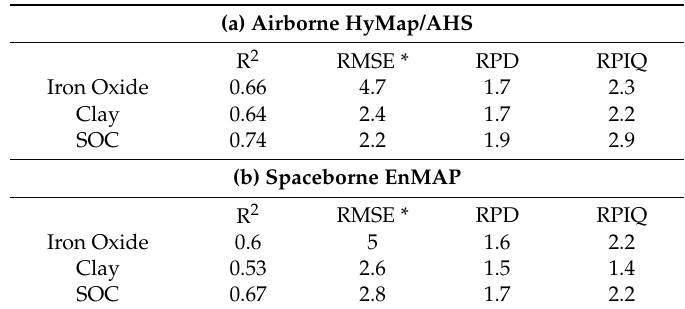
Table 3. Model performance statistics for the validation dataset was calculated and regression plots are depicted in ( a ) (HyMap/AHS) and ( b ) (simulated EnMAP). Top: Iron oxide content Cabo de Gata test site; Middle: clay content Cabo de Gata test site, Bottom: SOC content Luxembourg test site. * relates to different units of RMSE depending on the soil properties considered: RMSE is given in g oxide and SOC, RMSE is given in % for